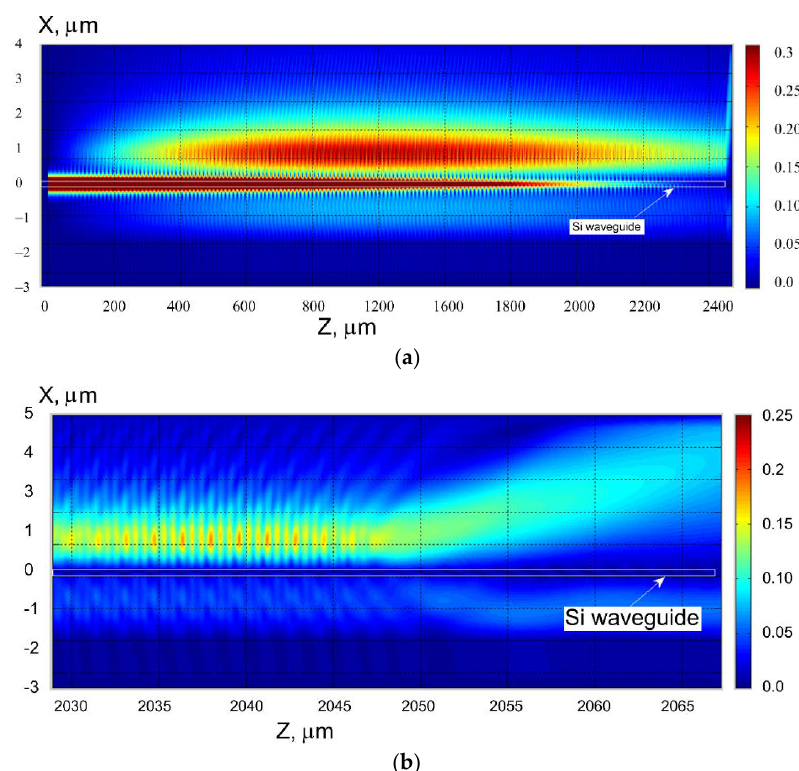
Figure 17. The effect of abnormal blocking for the forward diffraction. The dependence of the transmitting and reflection power of the fundamental mode of the silicon wire on the wavelength for different optimal number of segments ( M = 1280, 3169, 1615 and 3820). Each slope of the walls corresponds to its optimal number of segments and its abnormal blocking wavelength (with d 2 = 0.8 µm, vertical boundaries). Suppression of the transmitting wave is at level of −40 to −60 dB. Analysis made using 2D MoL plus EIM.